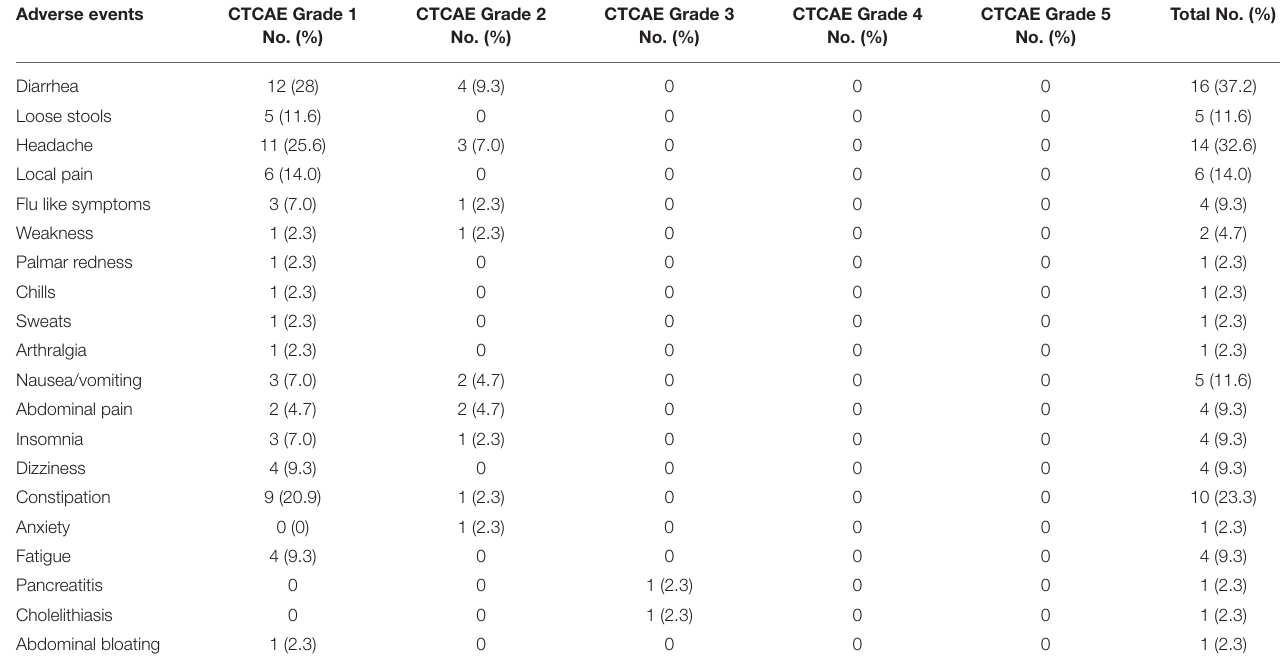
TABLE 2 | Treatment related CTCAE adverse events ( n = 43).